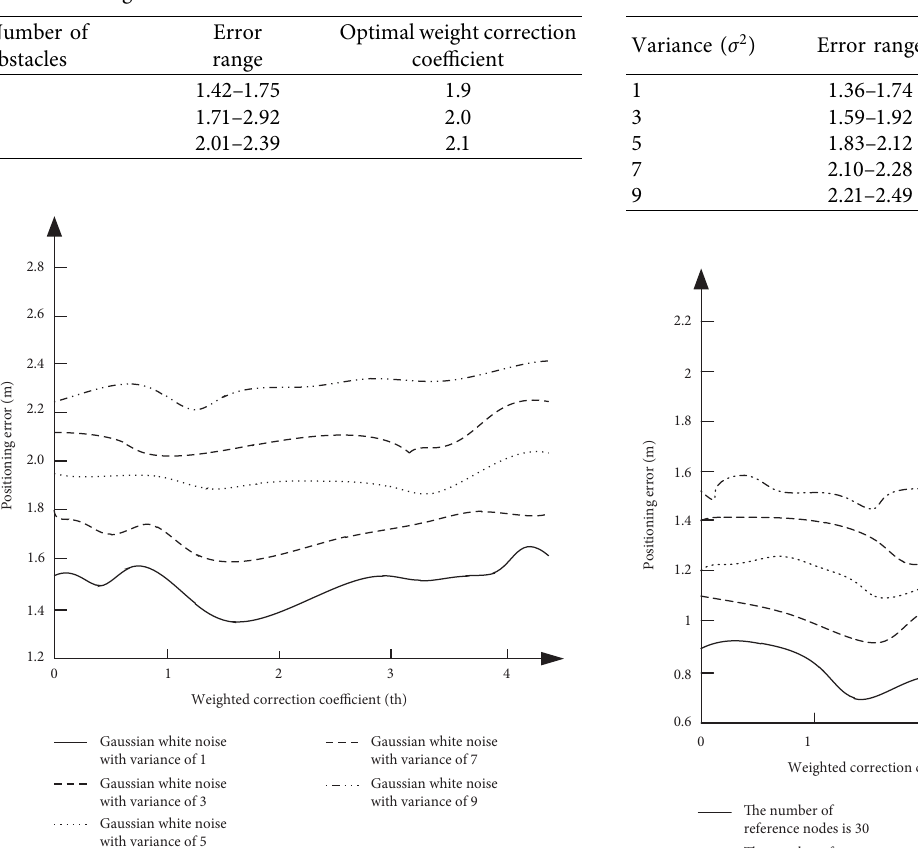
Table 2: Correction results of static weight correction coefficient under the change of the number of obstacles.